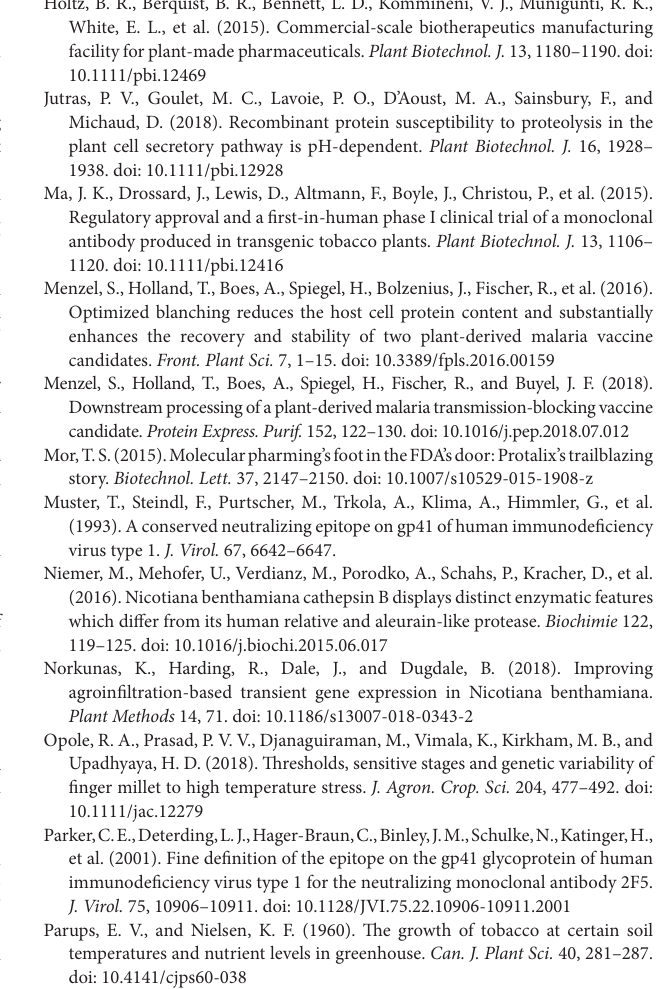
FIGURE S5 | Correlation between dependent biochemical and product parameters observed for a second set of six batches (2.1–2.6). Three harvests spaced 1 week apart were conducted per batch resulting in a total of 18 data points (dots). Dots are colored according to the DFE yield after purification. Lines represent linear regression models for the parameters in the corresponding row and column and are colored according to their p-value: green = p < 0.01, orange = 0.01 < p < 0.05 and gray = p ≥ 0.05. Histograms in the diagonal of panels represent the distribution of the parameter defined by the corresponding row/column. FIGURE S6 | Relative yield in dependence of harvest time. (A) Relative yield (ry) of DFE calculated using Equation 11 for each harvest of the second set of plant batches. (B) Relative yield of DFE with the harvest time adjusted so that the maximum yield was at time zero. Interestingly, no “U”-shaped sequence of yields was observed. The plot may be used to identify optimal cultivation times in dependence of the season and weather conditions. For example longer cultivation may result in higher DFE yields for batch 2.2 (> 55 dps), 2.4 (> 52 dps) and 2.5 (> 63 dps), whereas an optimal harvest was identified for 2.1 (50 dps) and 2.5 (56